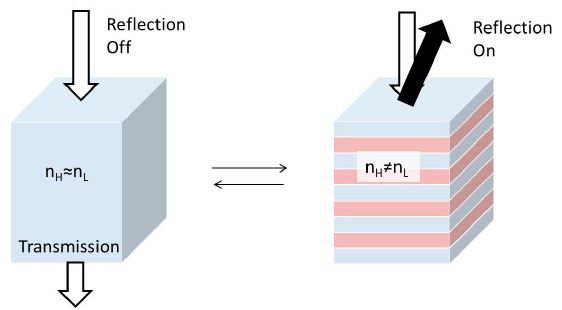
Figure 2. On–off switching of the reflection for the multilayered films of 1D PCs. Figure 2. On–o ff switching of the reflection for the multilayered films of 1D PCs.